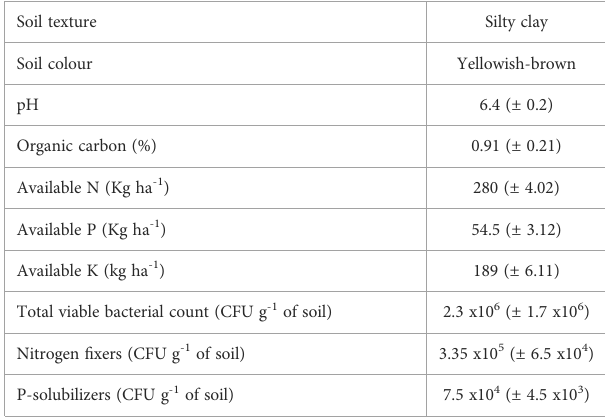
TABLE 1 Physicochemical properties and viable cell counts in the rhizosphere of L. camara L. Each value is the mean of three